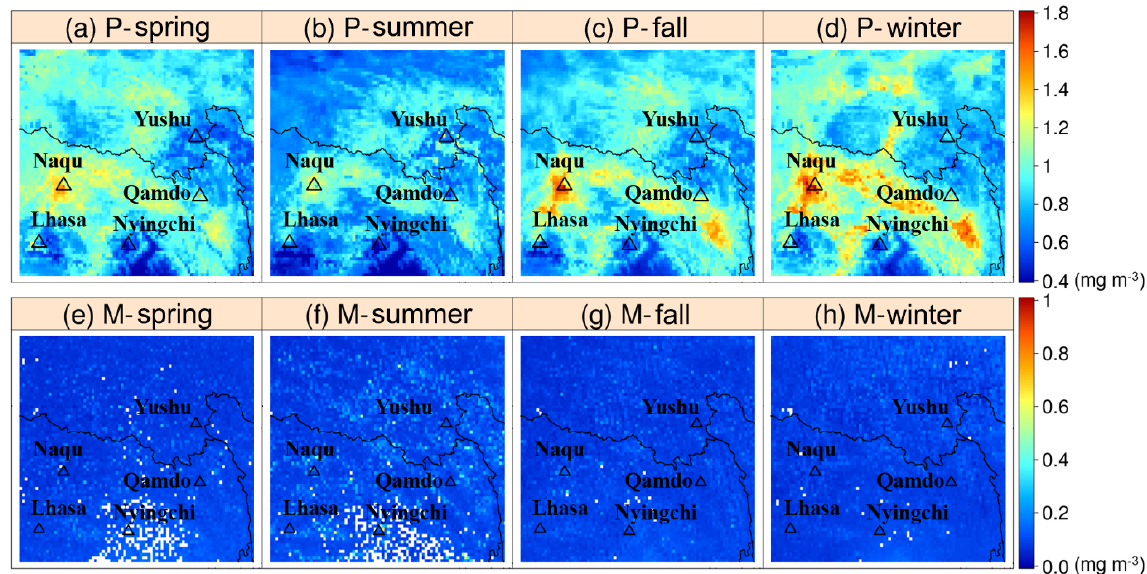
Figure 8. Seasonal average ground-level CO concentrations (mgm − 3 ) during 2013–2016 in the central Tibetan Plateau based on (a–d) the RF–STK predictions (P) and (e–h) the MOPITT retrievals (M). Main cities within this area (e.g., Lhasa, Naqu, and Qamdo) are annotated with